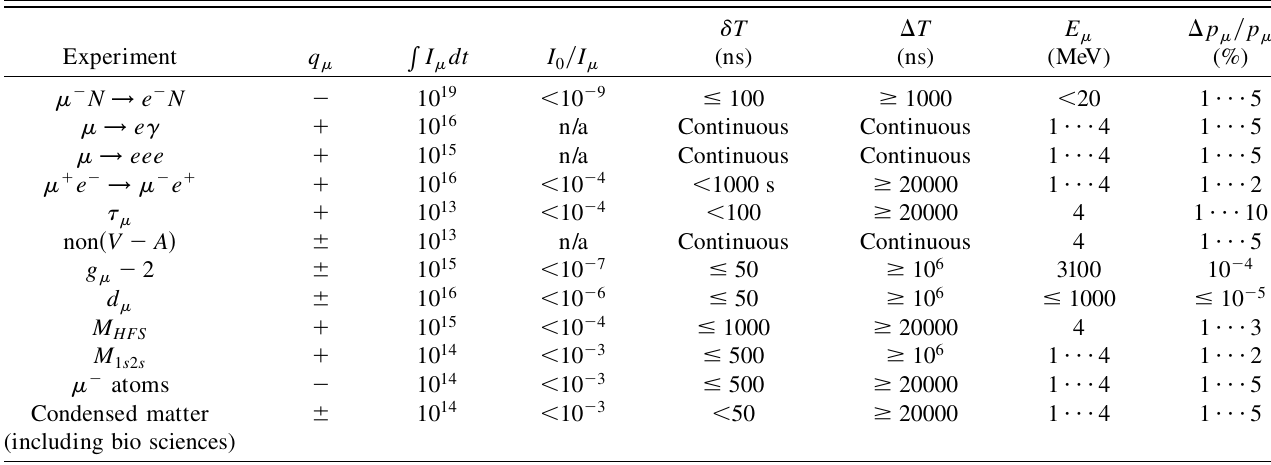
TABLE III. Beam requirements for new muon experiments.We show the needed muonic charge q dt above which significant progress can be expected in the physical interpretation of the experiments. muon number R I (cid:3) Measurements which require pulsed beams are sensitive to the muon suppression I (cid:24) T . Most experiments require energies up to 4 MeVcorresponding to 29 MeV =c momentum. Thin targets, respectively, storage ring acceptances, demand rather small momentum spreads (cid:24) p